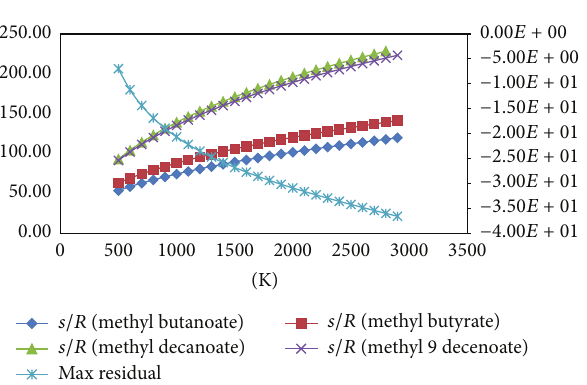
Figure 3: Variation of specific against temperature for biodiesel